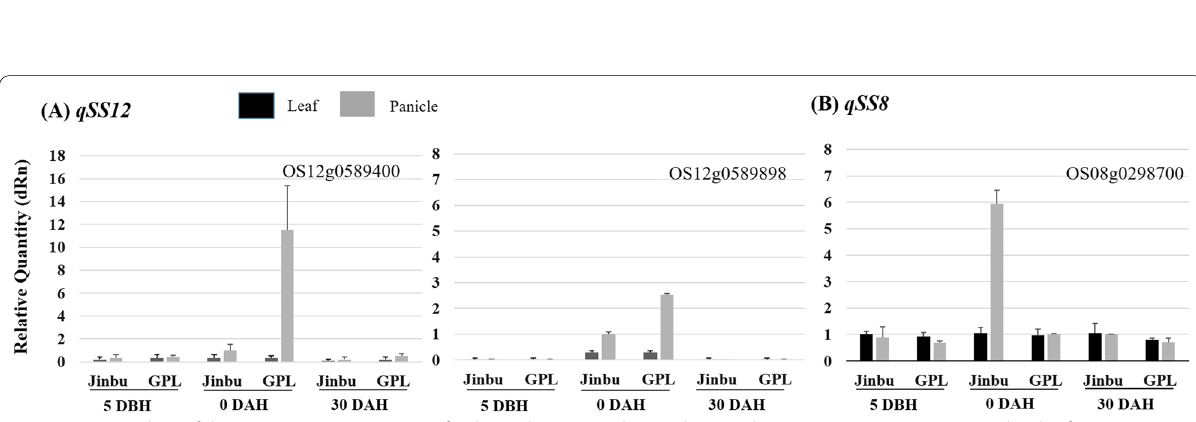
Fig. 5 qPCR analysis of the gene expression pattern of Jinbu and GPL according to the panicle maturing stage. A Expression levels of two ORFs in the target region of qSS12 . Panicles and leaves were collected from Jinbu and GPL at three time points: 5 days before heading (5 DBH), heading time (0 DAH), 30 days after heading (30 DAH). B Expression level of an ORF (OS08g0298700) in the target region of qSS8 under conditions identical to those in A. The black and gray bars show the expression levels in leaves and panicles, respectively. The eEF1-a gene was used as an